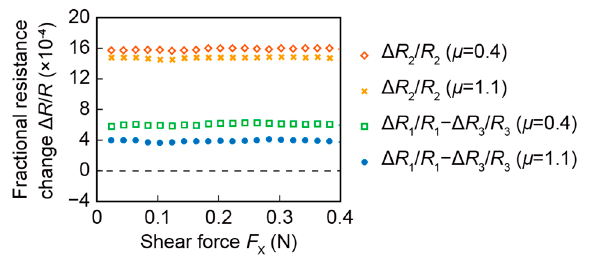
Figure 10. Response of the fabricated sensor to the shear force.